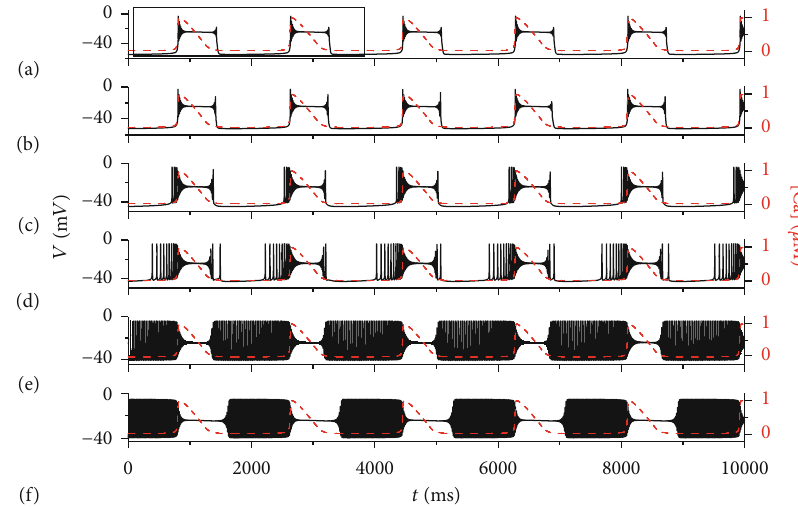
Figure 3: The full system (1a) – (3b) exhibits di ff erent fi ring patterns under di ff erent electric currents at k = 0 : 1 , k = 3s − 1 , α = 1M Ω − 1 , β 1 2 = − 2 μ A/c = 0 : 00006M Ω − 1 · V − 2 · s − 2 . The red dashed line represents the time course of intracellular calcium concentration [Ca]. (a) I extz m 2 ; (b) I = 5 μ A/cm 2 ; (c) I = 25 μ A/cm 2 ; (d) I = 30 μ A/cm 2 ; (e) I = 40 μ A/cm 2 ; (f) I = 50 μ A/cm 2 extz extz extz extz extz